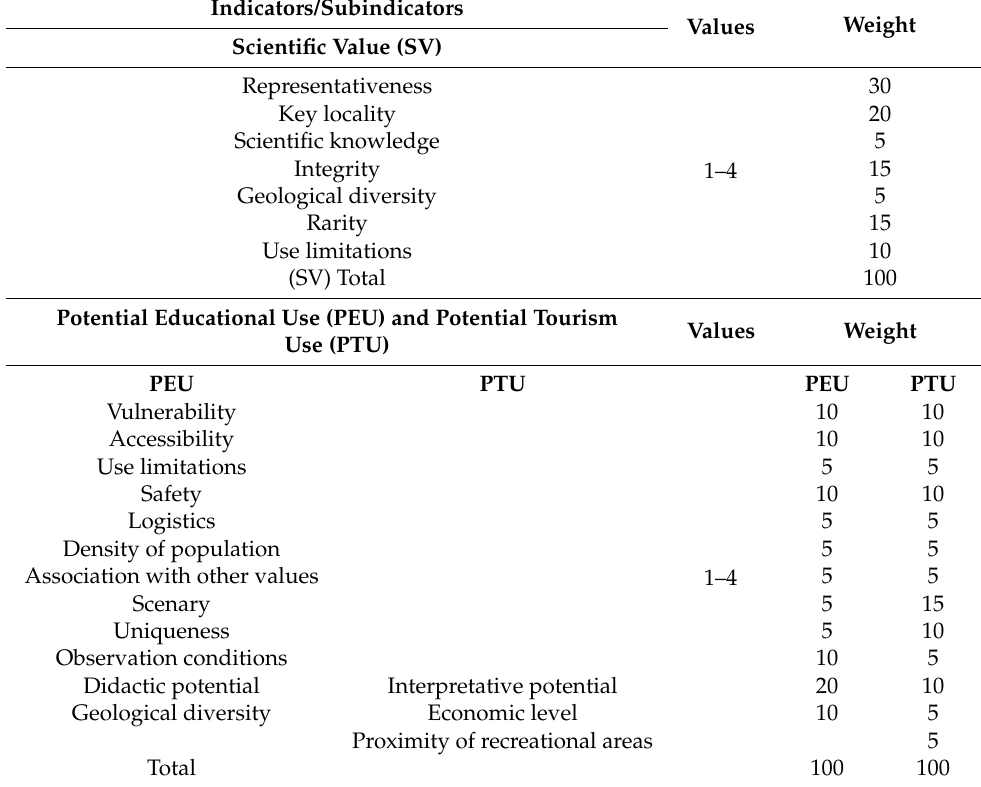
Table 2. Criteria and indicators used for the quantitative assessment of geosites